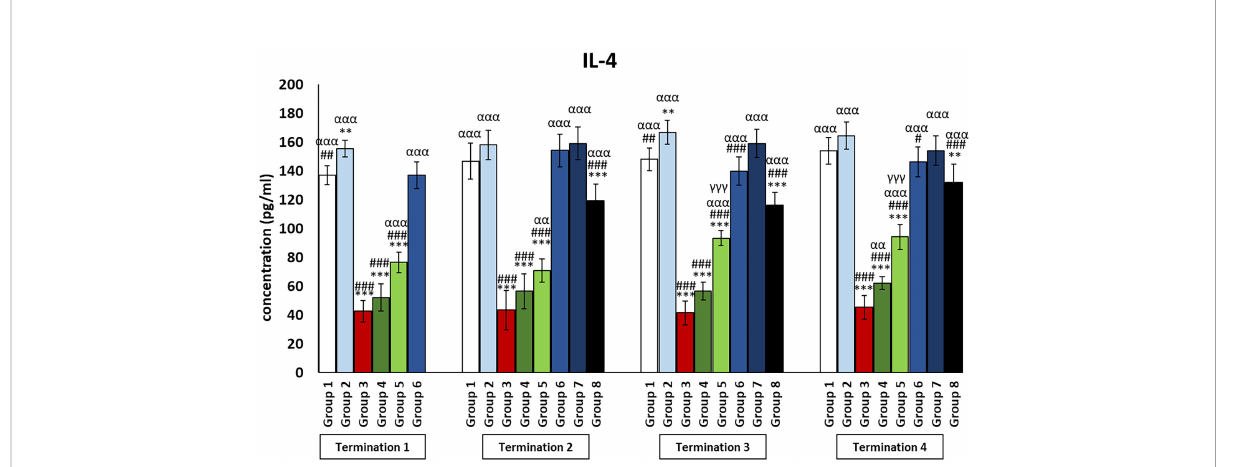
FIGURE 4 Changes in the levels of IL-4 in the blood of chickens receiving phage therapy or antibiotic therapy after 6, 20, 28, and 34 days of experiments. Results are presented as mean values ± SD. Statistical analyses were performed by Kruskal – Wallis test and post-hoc Dunn test or ANOVA and post-hoc Tukey ’ s test. The signi fi cance of differences between controls and particular treated groups is observed and marked by the following: asterisks (*) vs. saline control; (#) vs. phage control (group 2); (a) vs. infected control (group 3); (g) vs. termination 2. p < 0.001 (***, ###, aaa , ggg ), p < 0.01 (**, ##, aa ), and p < 0.05